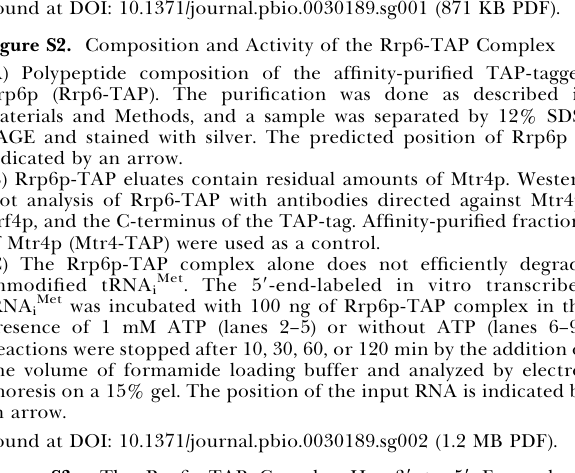
Table S1. Proteins Interacting with Full-Length Trf4p in a Yeast Two-Hybrid Screen ‘‘ Start ’’ and ‘‘ stop ’’ indicate regions of proteins expressed in particular clones. Numbers in brackets indicate that the clone extended beyond the open reading frame. Global predicted biological score (PBS) is a confidence score assigned to each interaction by Hybrigenics, which predicts the occurrence of an interaction in vivo